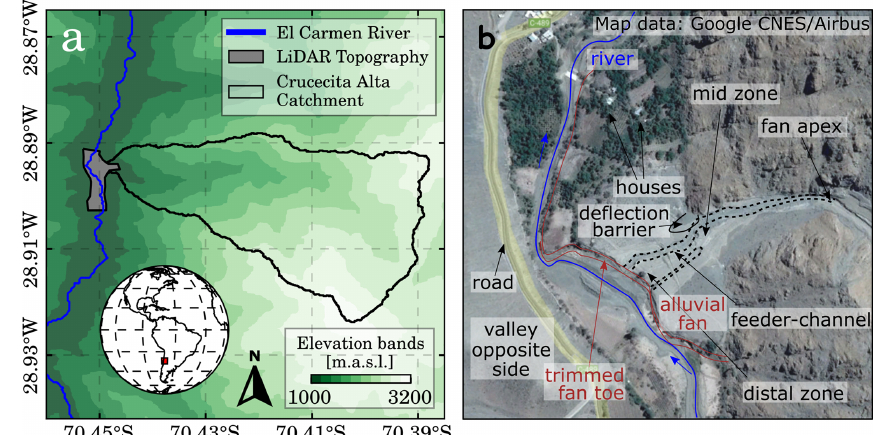
Figure 1. Study area. (a) Crucecita Alta catchment (28.895569 ◦ S, 70.449925 ◦ W). The gray polygon is the river segment that includes the studied fan topography section used in the FLO-2D numerical model. The unfilled polygon depicts the Crucecita Alta catchment (13km 2 ). (b) Crucecita Alta alluvial fan main geometric features where the feeder-channel, generated during the 25M event, is marked with dotted lines. Map data: Google Earth Pro (CNES/Airbus) taken in October 2016 (post